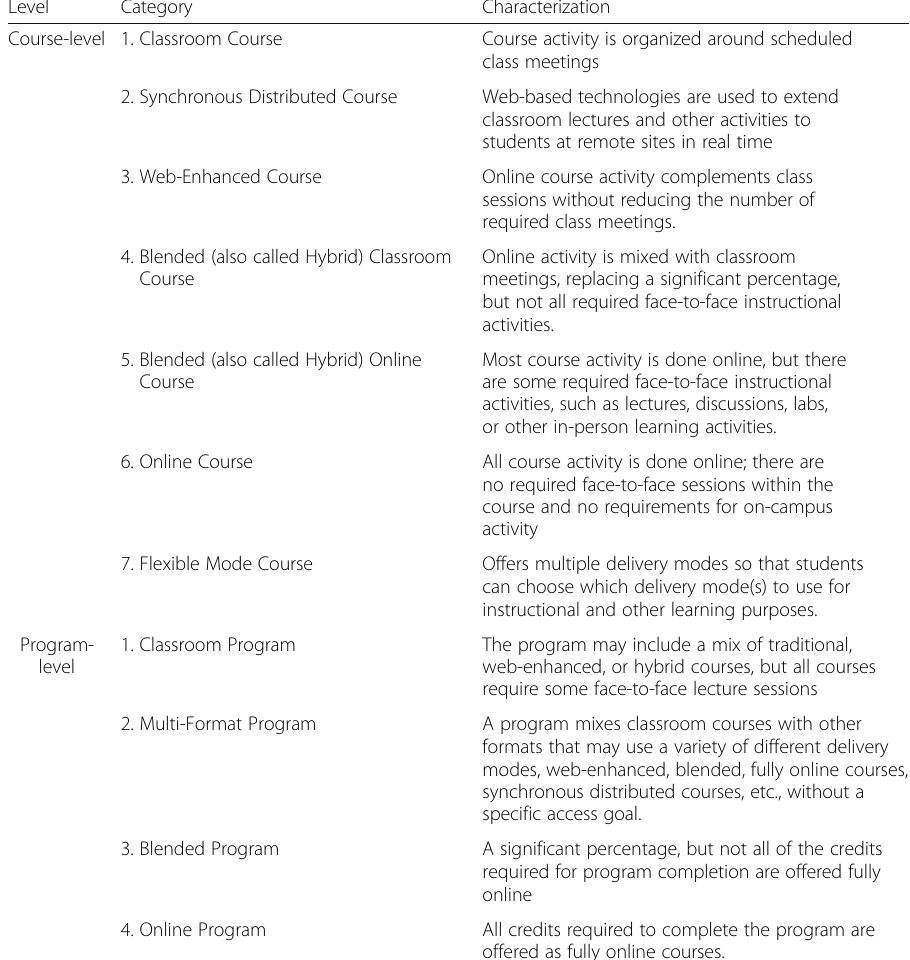
Table 7 Updated definitions of eLearning Courses and Programs, Version